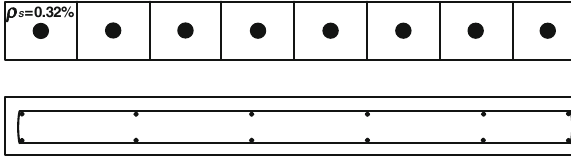
Fig. 4 Auto-sized fiber section for wall